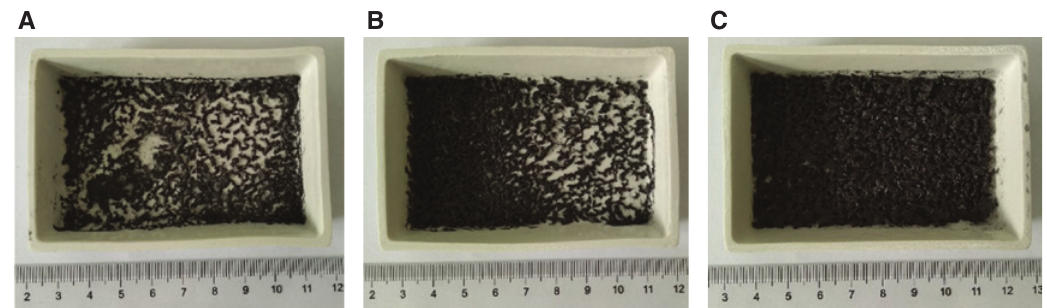
Figure 8: Residues of LDPE/EVA composites (A) LDPE + 3% CF; (B) LDPE + 6% CF; (C) LDPE + 12%